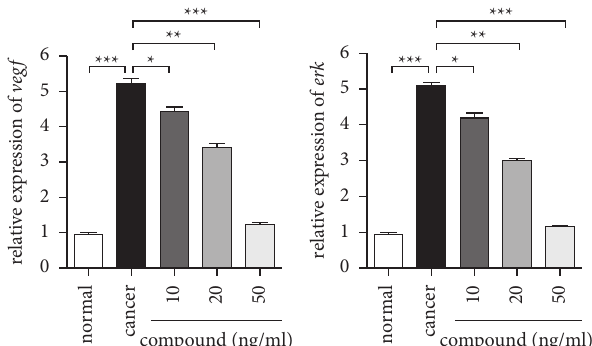
Figure 5: Activation level of VEGF signaling pathway in gastric cancer cells decreased due to the effect of compound 1 . Specifically, gastric cancer cells were inoculated into 96-well plates and treated with the new compound for 2 days. Real-time RT-PCR was used to study the opening of this pathway after compound